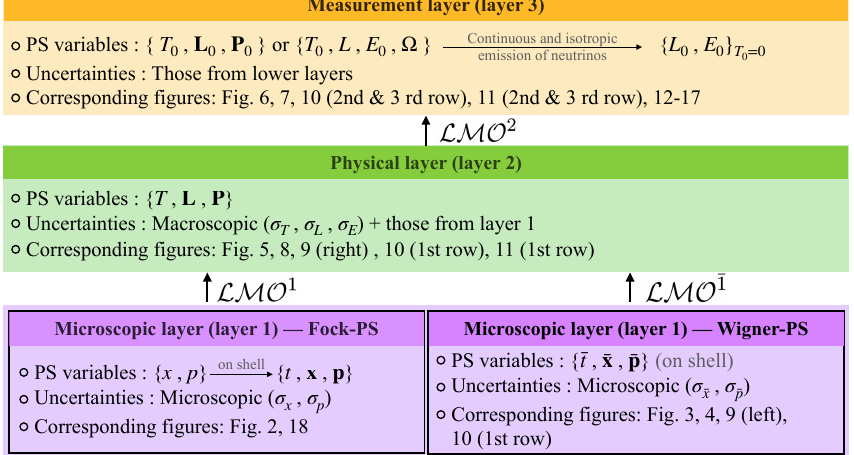
Figure 1 . Illustration of the layer structure, and the notation of each phase space variable deciding the kinematics of states: t, ¯ t, T, T are the temporal variables; x , ¯ x , L , L are the spatial variables; 0 0 and p , ¯ p , P , P are the momentum variables; E is the energy and Ω represents the solid angle. 0 0 The layers are linked by the layer-moving operator in eq. (2.1), and the uncertainties are discussed in the